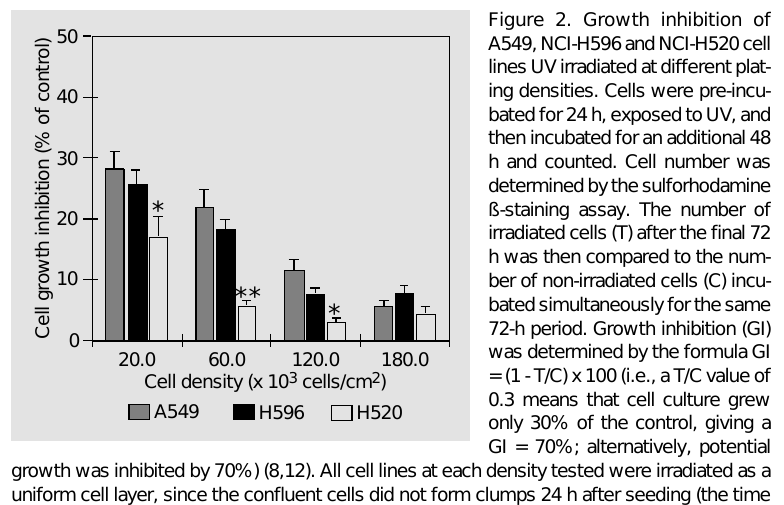
Figure 3. Proliferative status and DNA fragmentation of A549, NCI- H596 and NCI-H520 cell lines at 60 x 10 3 cells/cm 2 . A , Cells cultured for 24 and 48 h were counted by the sulforhodamine ß-staining as- say. Percent cell growth is ex- pressed as increased cell number between 24 and 48 h of incuba- tion. B , Cells were pre-incubated for 24 h in medium containing [methyl- 3 H]-thymidine, washed, and UV irradiated, and then new medium was replenished without [methyl- 3 H]-thymidine. Irradiated and control cells were then incu- bated for an additional 48 h and at the end of this period the medium was aspirated and counted in a liq- uid scintillation counter. The cells attached to the plate were lysed and then centrifuged for 15 min at 14,000 rpm. Subsequently, both the supernatant and the remaining pellet containing larger DNA frag- ments were counted. Percent DNA fragmentation was calculated by summing the counts in the medi- um and the supernatant and divid- ing by the total counts, taking into account irradiated and control cells as described in Material and Meth- ods (13,14). The cells did not form clumps 24 h after seeding (the time needed for cells to recover from trypsin treatment); therefore, all